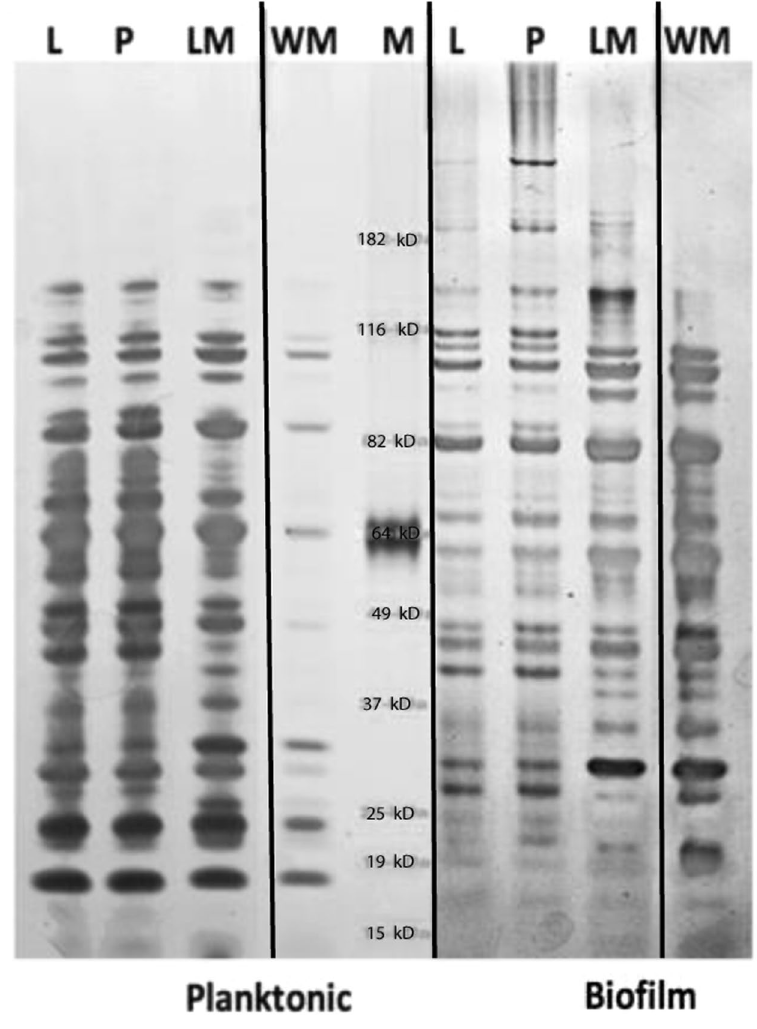
Figure 4. Electrophoretic protein profiles of LVS variants or mutants grown as a biofilm or are planktonic cells from the biofilm broth supernatant. Bacterial strains were grown as a biofilm in CDMB for 25 days, the medium above the biofilm was removed, and the planktonic cells harvested by centrifugation. Planktonic cells in the medium and cells in the biofilm were extracted with 1 M urea. The protein profiles were resolved by SDS-PAGE on 4-12% gels and stained with silver. Strains: L, LVS; P, LVS_P10; LM, LVS Δ 1423-22; WM, WbtI G191V Δ 1423-22; M, Molecular size standards. The figure is a compilation of four separate gels containing samples prepared during the same experiment (left two are from planktonic phase cells and right two are from biofilm cells), which have been cropped to present the most relevant information (original shown in Supplementary Fig. S3). Precipitates of the broth medium are not shown. Lanes of WbtI G191V (W) have been deleted from the planktonic cells (far left) and from the biofilm cells (far right) due to lack of differences with WbtI G191V Δ 1423-22 (WM). Repeated subculture in CDMB had little effect on protein composition, but loss of surface glycoses, particularly O-Ag, or growth as a biofilm substantially altered the protein